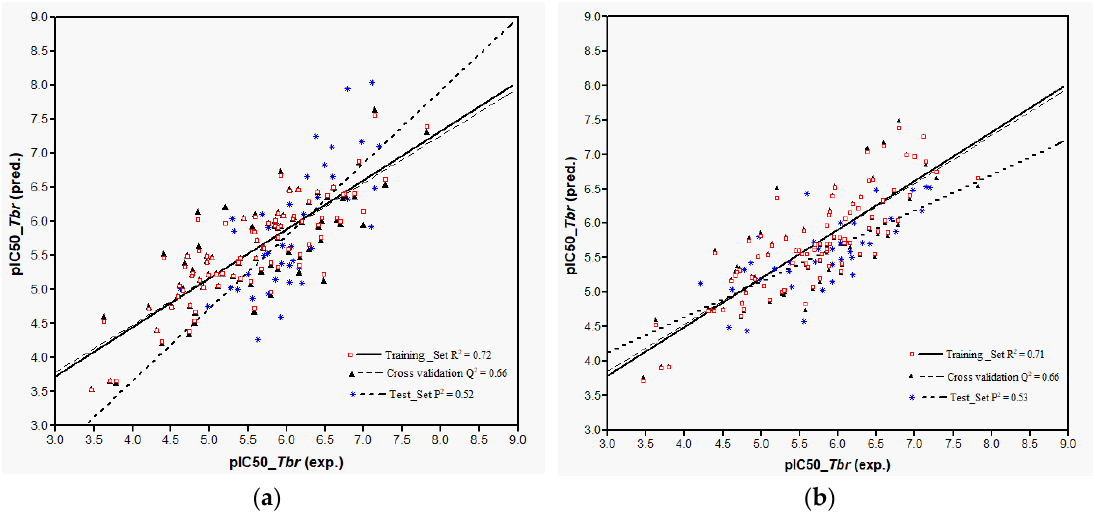
Figure 2. Plot of predicted versus experimental pIC 50 values as obtained from the QSAR: ( a ) Model 1 represented by the first equation in Table 1; ( b ) Model 2 represented by first equation in Table 2. Note that three outliers were removed from the test set.